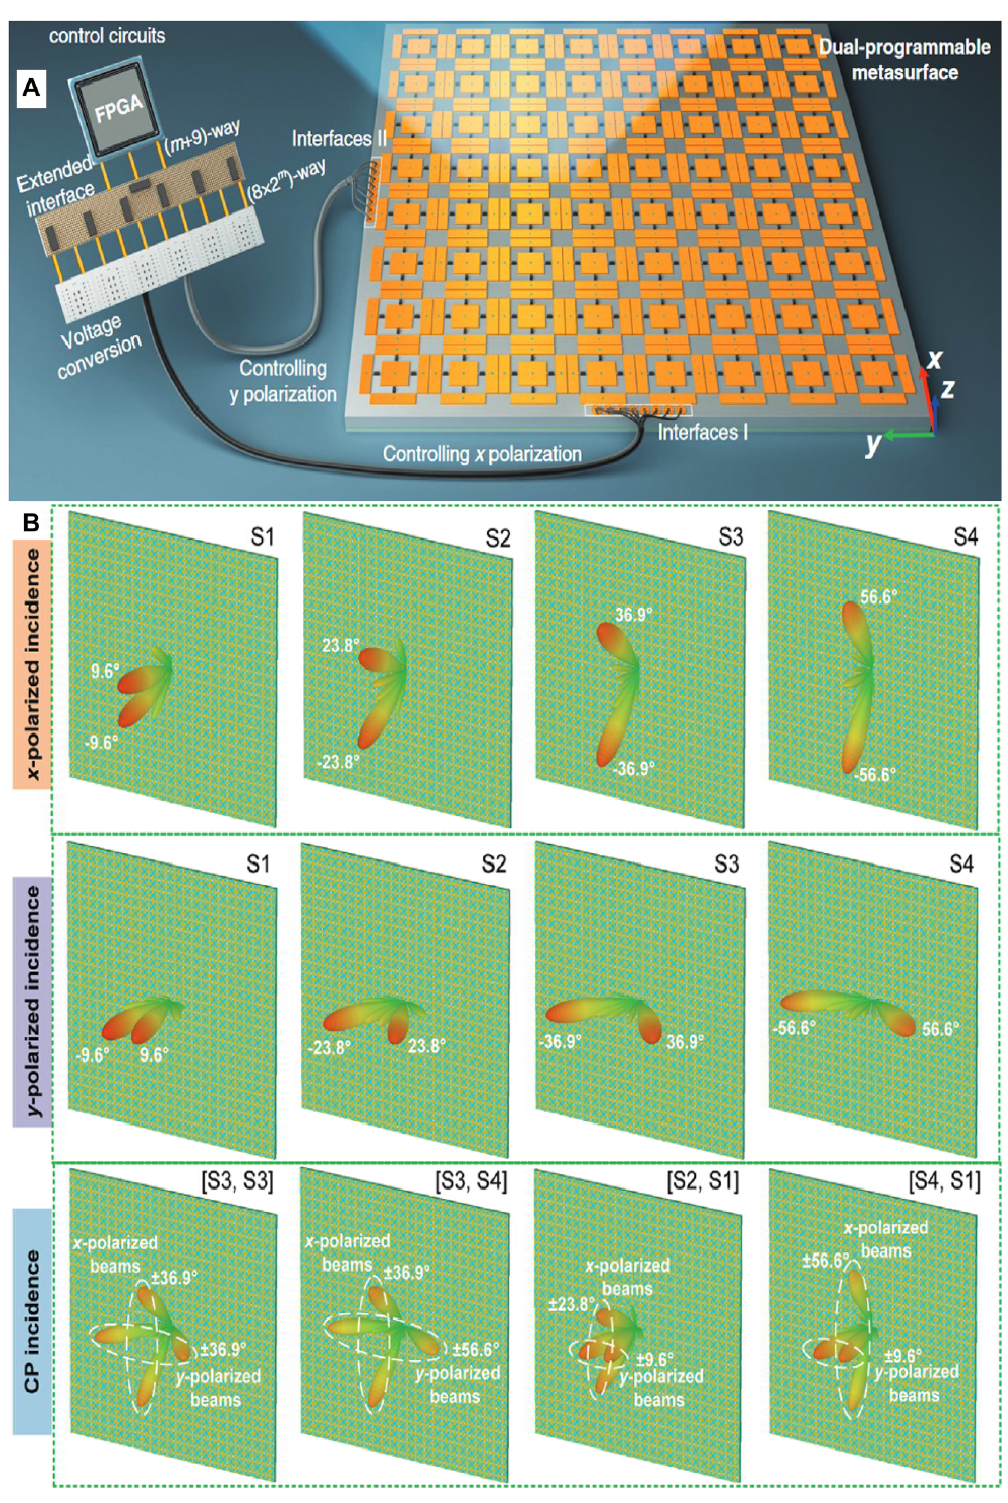
Figure 23: FPGA programmable metasurface.